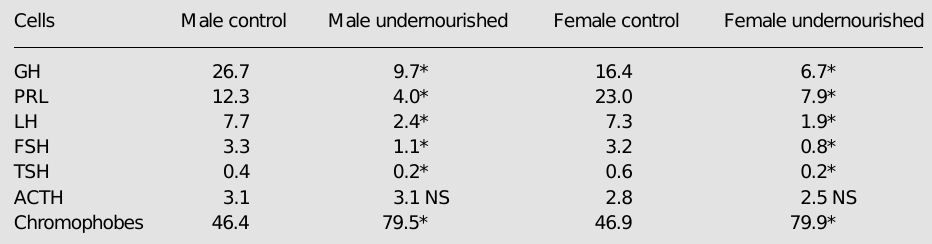
Figure 5 - Electron micrograph of a GH cell from an undernour- ished monkey showing an ex- panded and dilated Golgi com- plex (G). Several secretory gran- ules are contacting the plasma membrane (arrows)